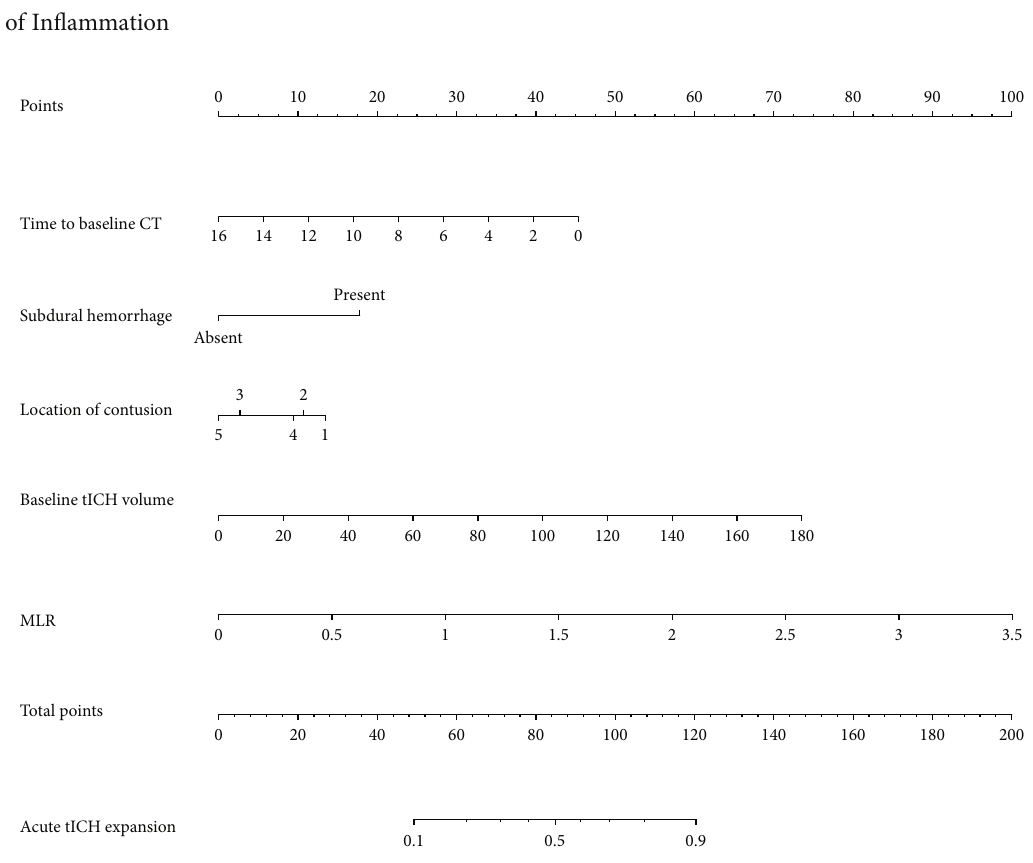
Figure 6: The nomogram derived from the MLR model to predict acute tICH expansion. To calculate a patient ’ s acute tICH expansion probability, points for each parameter are assigned by corresponding values from the “ points ” axis, and sum of the points is plotted on “ total points ” axis. The patient ’ s acute tICH expansion probability is the value at a vertical line from the corresponding total points. In the “ points ” axis of location of contusion, “ 1 ” represents a frontal lobe contusion; “ 2 ” represents a temporal contusion; “ 3 ” represents a